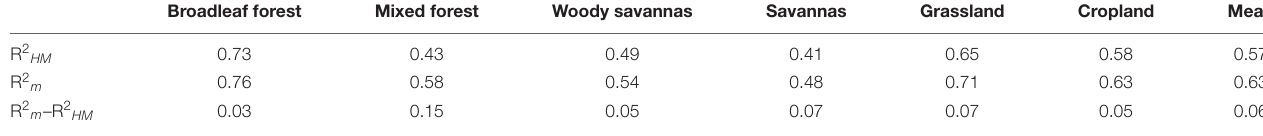
under the Topic Humid South China (THSC) of southeast China. Under different precipitation regions, the effect of DRT on NDVI was weakest under the 200–600 mm precipitation